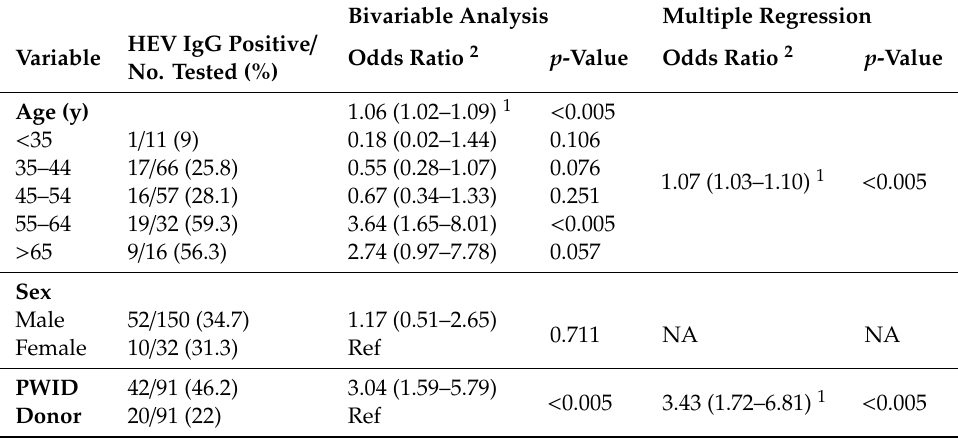
Table 1. E ff ect of age, gender and addictive injection use on HEV IgG serostatus.